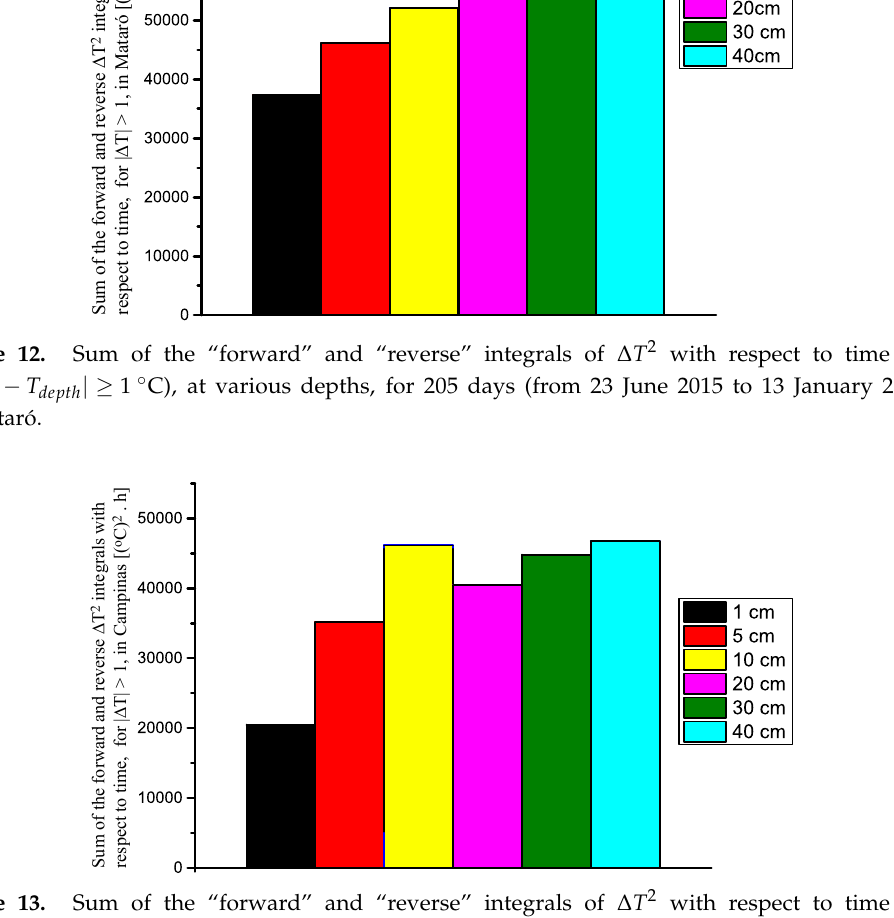
Figure 13. Sum of the “forward” and “reverse” integrals of ∆ T 2 with respect to time (for | T − T | ≥ 1 ◦ C), at various depths, for 32 days (5 July to 5 August 2015), in plate depth